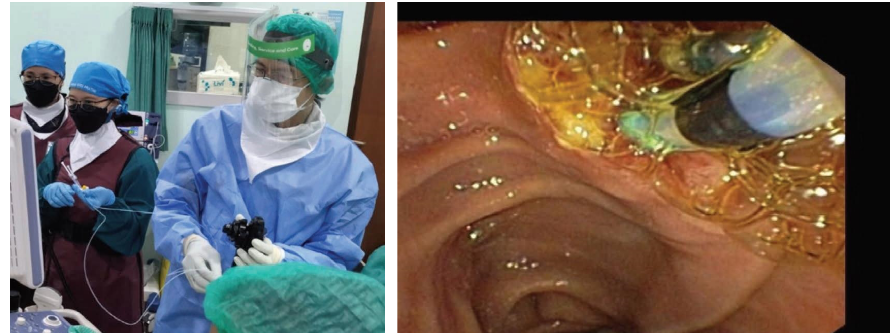
Figure 2: Beriplast injection procedure using two 5-Fr catheter.